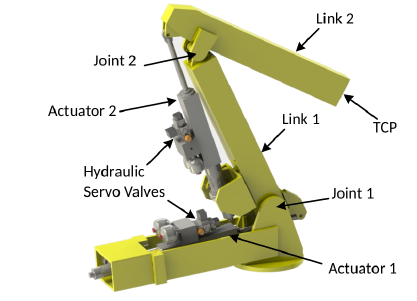
Figure 1: Illustration of the hydraulically actuated ma-